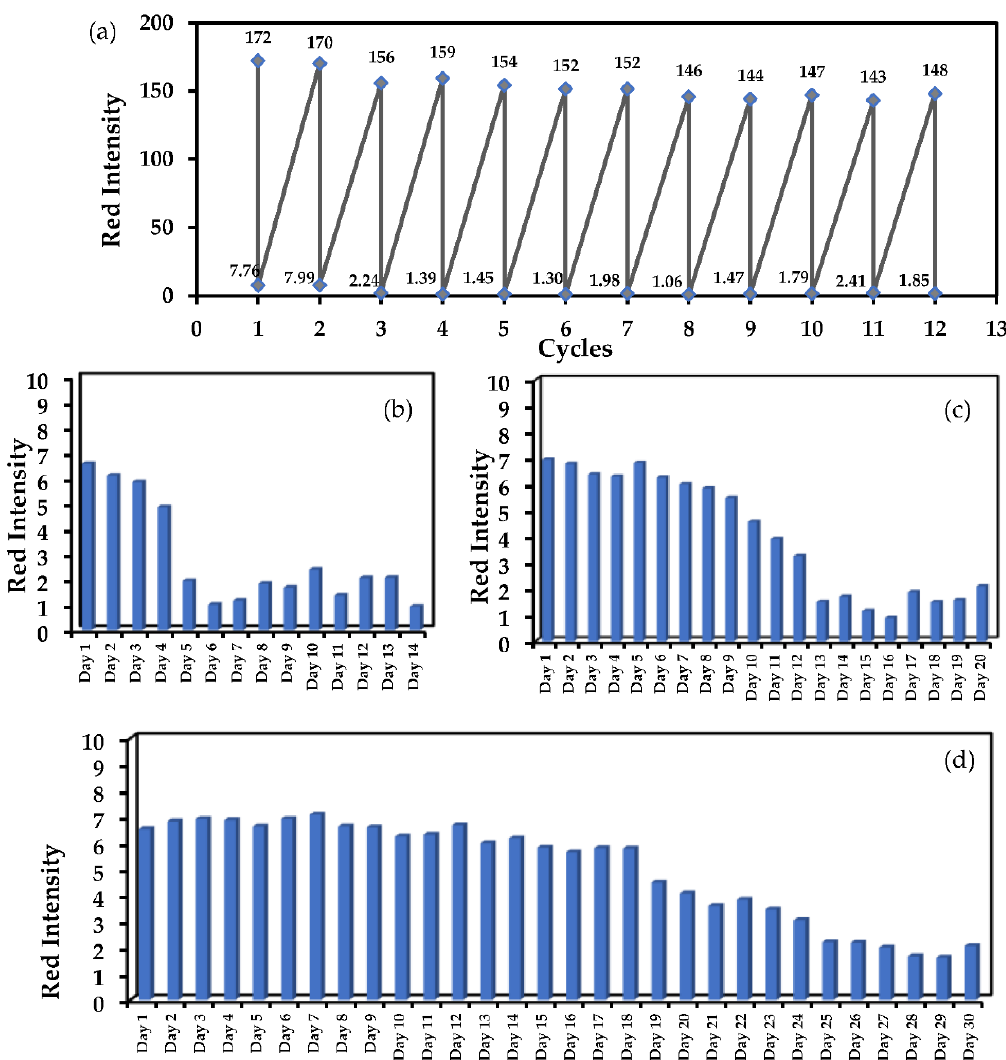
Figure 8. (a ) The cycle regeneration MIPs@EDA-CDs/CF in the absence of MT (lower dashed line) and presence (upper dashed line) of 1000 μg/L MT, ( b ) the stability of MIPs@EDA-CDs/CF under normal light, ( c ) the stability of MIPs@EDA-CDs/CF in a dark place, and ( d ) the stability of MIPs@EDA- CDs/CF in a refrigerator (4−8 °C). Table 2. The adsorption capacity and the partition coefficient of the MIPs@EDA-CDs/CF and